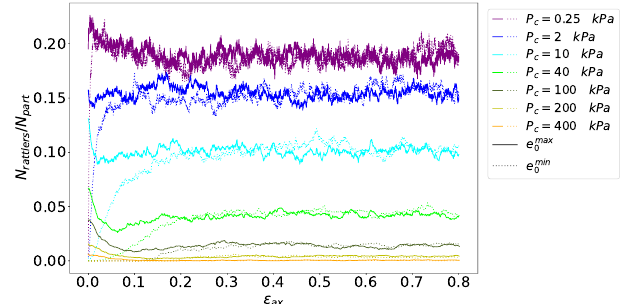
Figure 7. Proportion of rattlers in S2 simulations